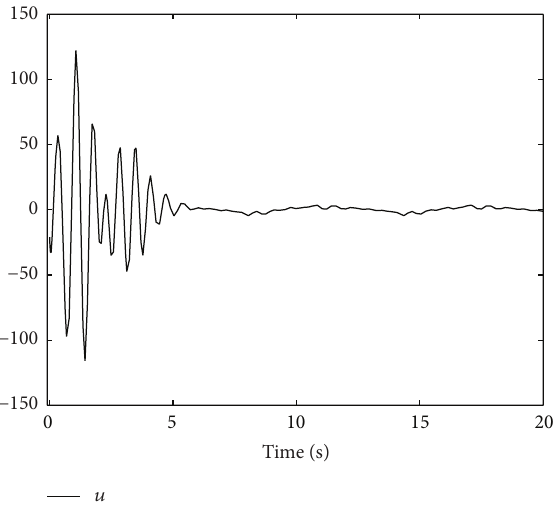
Figure 4: The trajectory of 𝑢 .